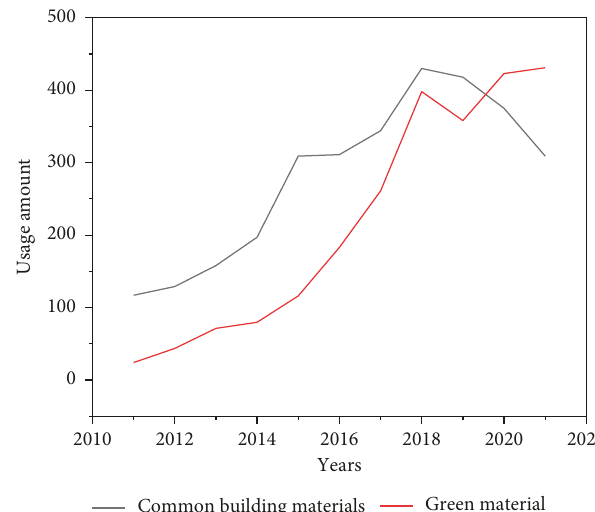
Figure 5: The usage curve of common building materials and green materials.